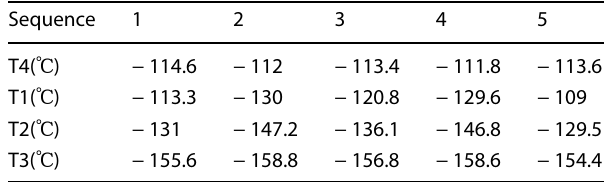
Table 4 24-h stable production data after adjustment